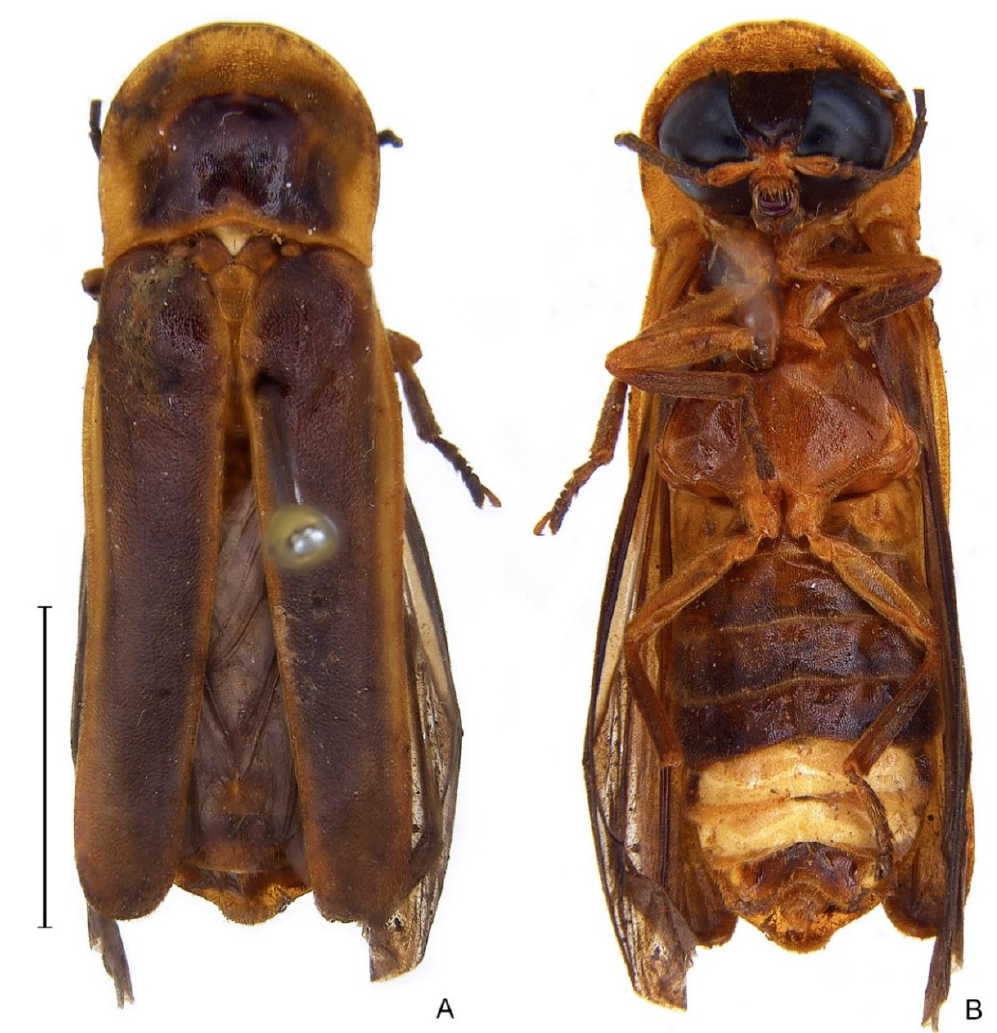
Figure 7. Zoiudo araucariorum sp. nov., habitus ( A ) dorsal, ( B ) ventral. Scale bar: 5 mm.